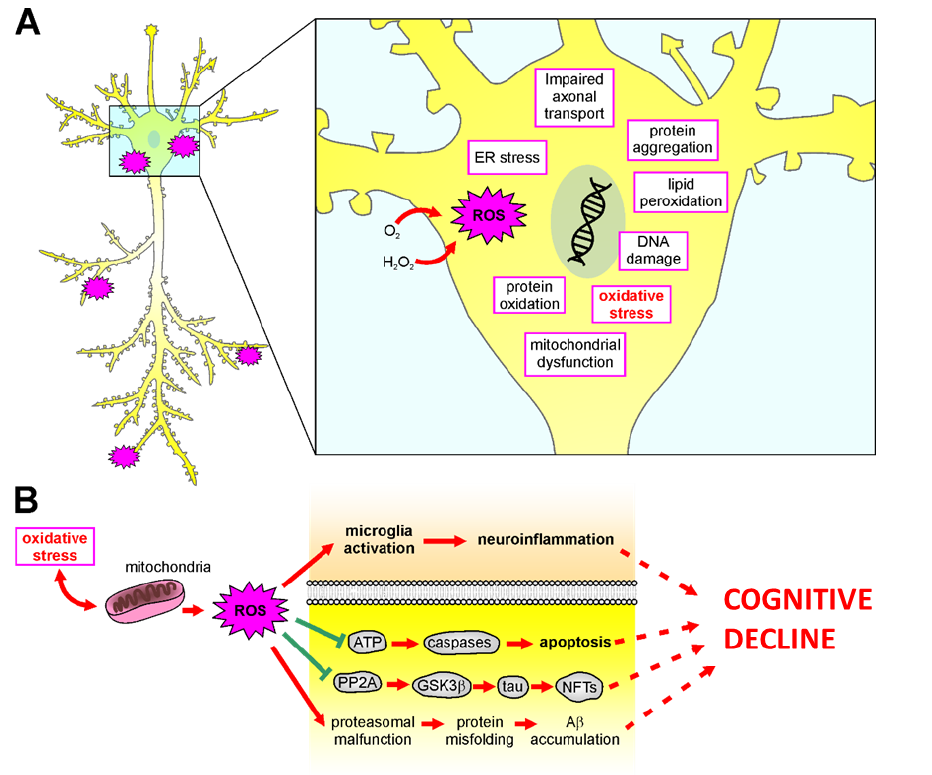
Figure 3. Mechanisms of oxidative stress in the brain. ( A ): Schematic representation of all damaging molecular mechanisms involved in ROS-mediated insult in neurodegenerative diseases. ( B ): Oxidative stress causes mitochondrial damage and ROS release, damaging neurons and leading to neuronal dysfunctions and cognitive decline by: (1) inducing microglia activation leading to neuroinflammation; (2) impairing ATP release, leading to caspase-dependent apoptotic pathways; (3) increasing neurofibrillary tangles (NFTs) accumulation caused by hyperphosphorylation of tau thought decreased PP2A activity and increased GSK3β; (4) facilitating misfolding protein aggregation as Ab accumulation.